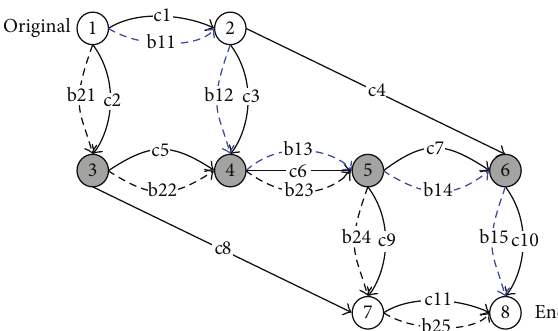
Figure 1: Numerical network including two modes.